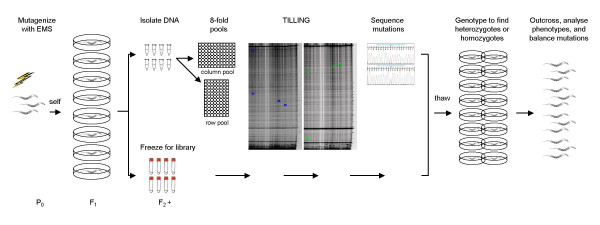
Outline of C. elegans TILLING procedure. Animals are mutagenised with EMS, picked individually to plates, and allowed to self. One third of the worms are used for DNA and the remaining two thirds are frozen for future analysis. DNA is pooled 8-fold to reduce time and expense. TILLING is performed in order to determine which individuals carry mutations in the gene of interest. Mutations are sequenced and individuals from lines carrying mutations that have an effect on the gene product are thawed and genotyped to isolate heterozygous or homozygous mutants.